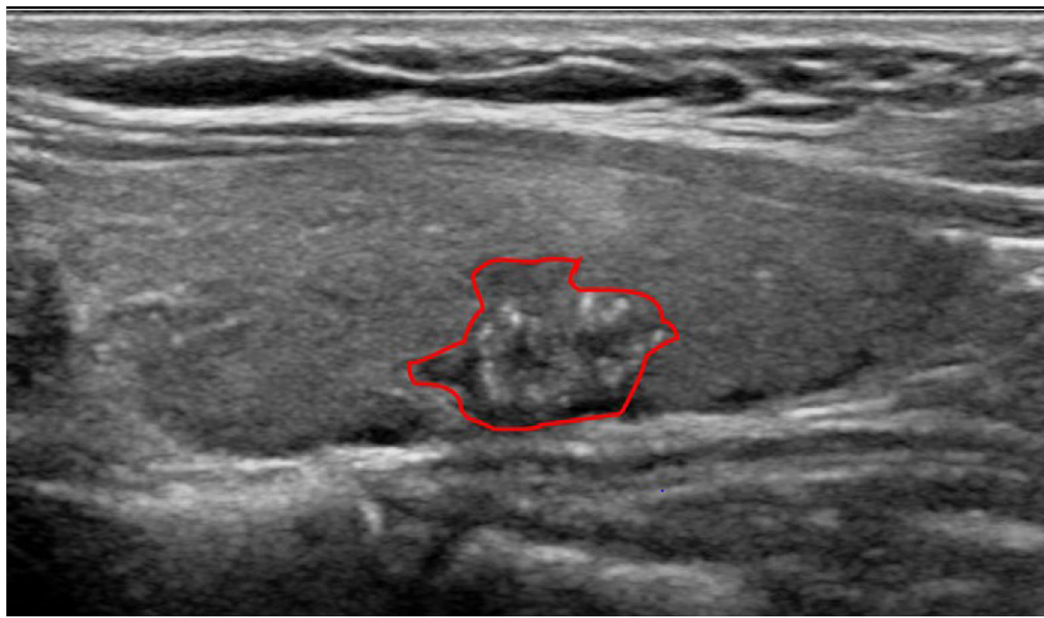
Fig 1. Representative image of tumor segmentation using thyroid US. A diagonal region-of-interest (ROI) was drawn along the tumor border (red line) for feature extraction.